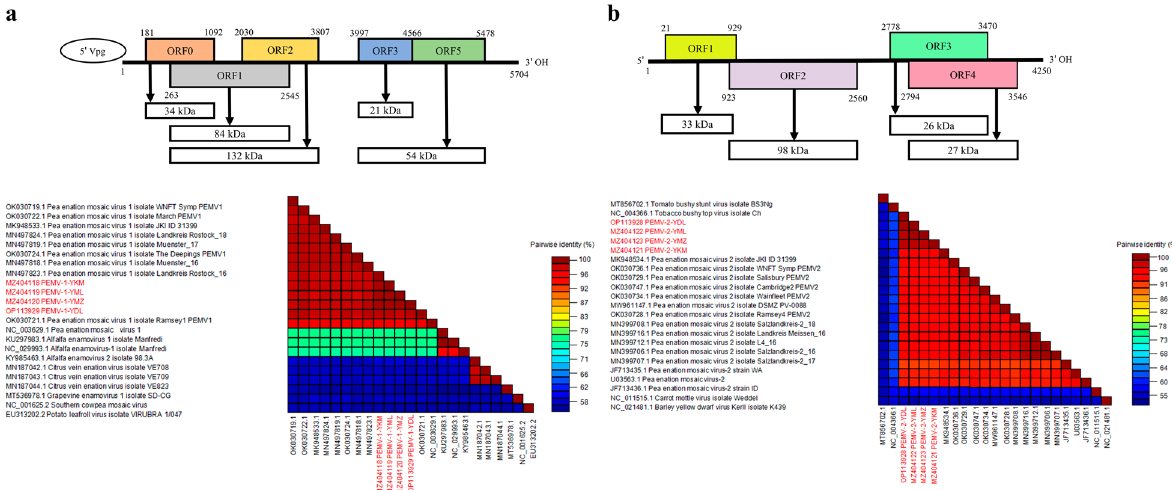
Fig. 2 Genome organization of PEMV-1 and PEMV-2, and pairwise identity matrices of the full-length genome sequences generated by the Sequence Demarcation Tool version 1.2. a Genome organization of PEMV-1 and pairwise identity matrix of PEMV-1 and other viruses in the genus Enamovirus , Polerovirus , and Sobemovirus in the family Solemoviridae . b Genome organization of PEMV-2 and pairwise identity matrix of PEMV-2 and other viruses in the genera Umbravirus , Tombusvirus , and Luteovirus of the family